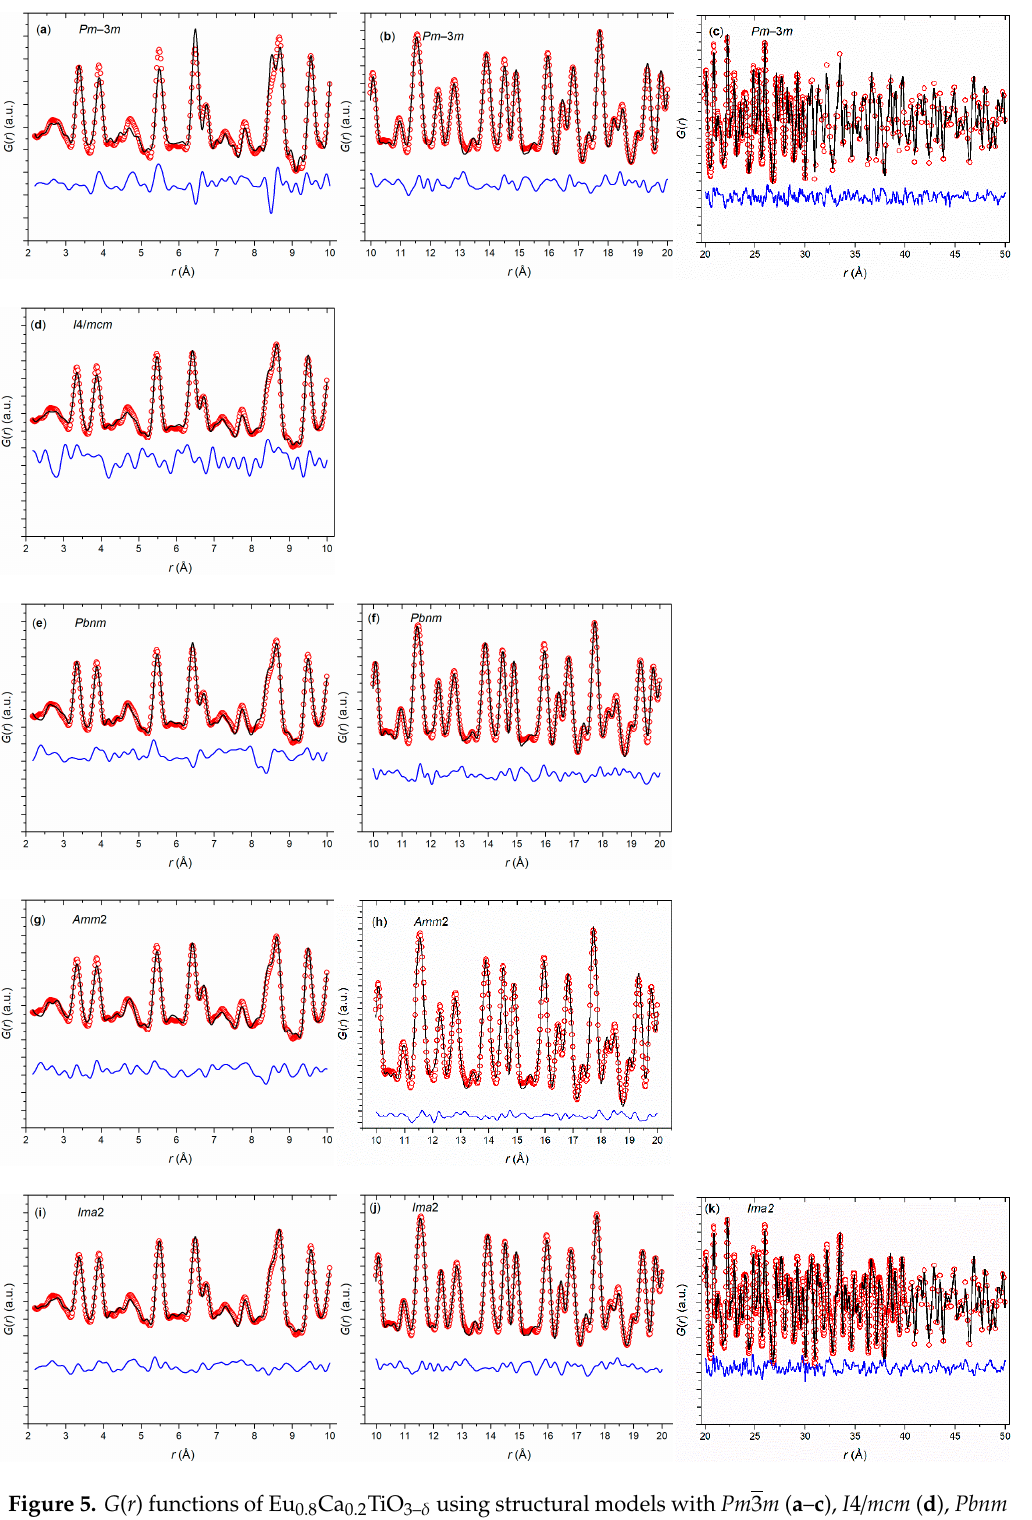
Figure 5. G ( r ) functions of Eu 0.8 Ca 0.2 TiO 3– δ using structural models with Pm 3 m ( a – c ), I 4 / mcm ( d ), Pbnm ( e – f ), Amm 2 ( g – h ), and Ima 2 ( i – k )